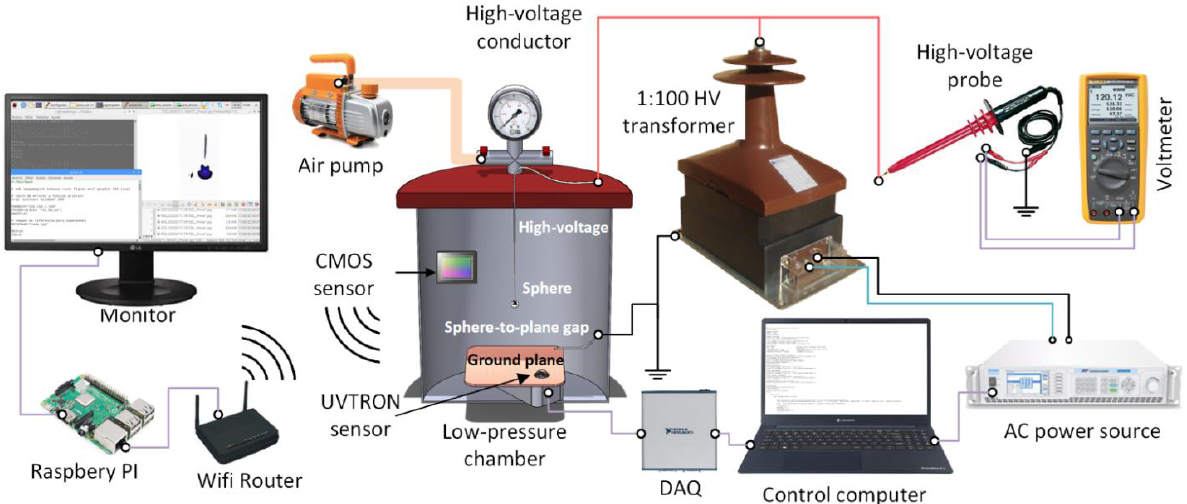
Figure 3. Experimental Setup. Diagram of the experimental setup including the instrumentation used for the detection of corona in the high-voltage tests with their respective diametric measures. The sphere-to-plane gap was composed of a grounded square-shaped copper plate and stainless steel bearing balls (Homsyway, Shenzhen, China) of diameters ranging from 2 mm to 10 mm attached to stainless steel tubes of diameters ranging from 0.75 mm